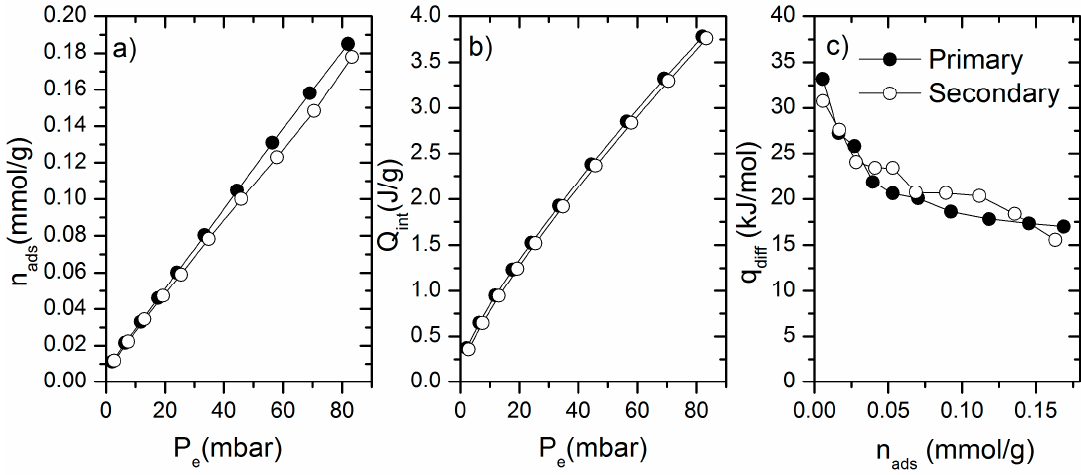
Figure 8. ( a ) Volumetric isotherm ( b ) calorimetric isotherm and ( c ) differential heat distribution of CO 2 adsorption measured at 30 °C on Ce 5 (BDC) 7.5 (DMF) 4 activated at 350 °C.